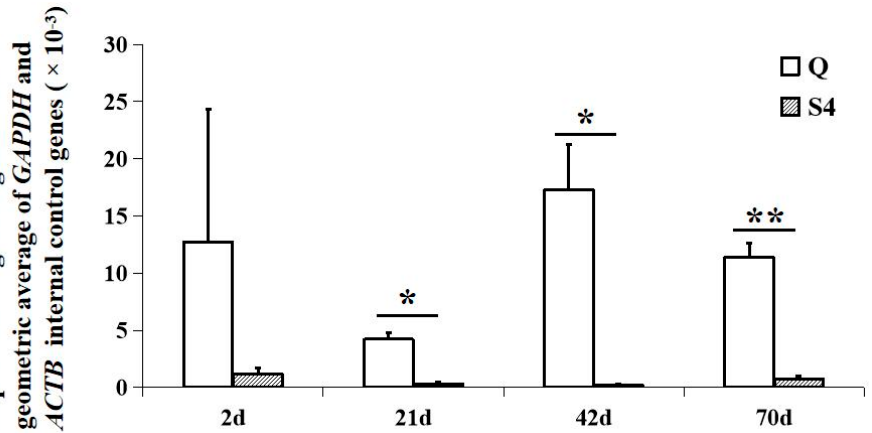
Figure 3. Expression of BCO2 in chicken back skin at four different times. Relative expression analyses in back skin of BCO2 gene were normalized to the geometric average of ACTB ( β -actin) and GAPDH genes. Error bars represent the SE; * and ** indicate significant differences at p ≤ 0.05 and p ≤ 0.01, respectively, in gene expression between the Qingjiao Ma (Q) and Guangxi Huang (S4) chicken breeds.